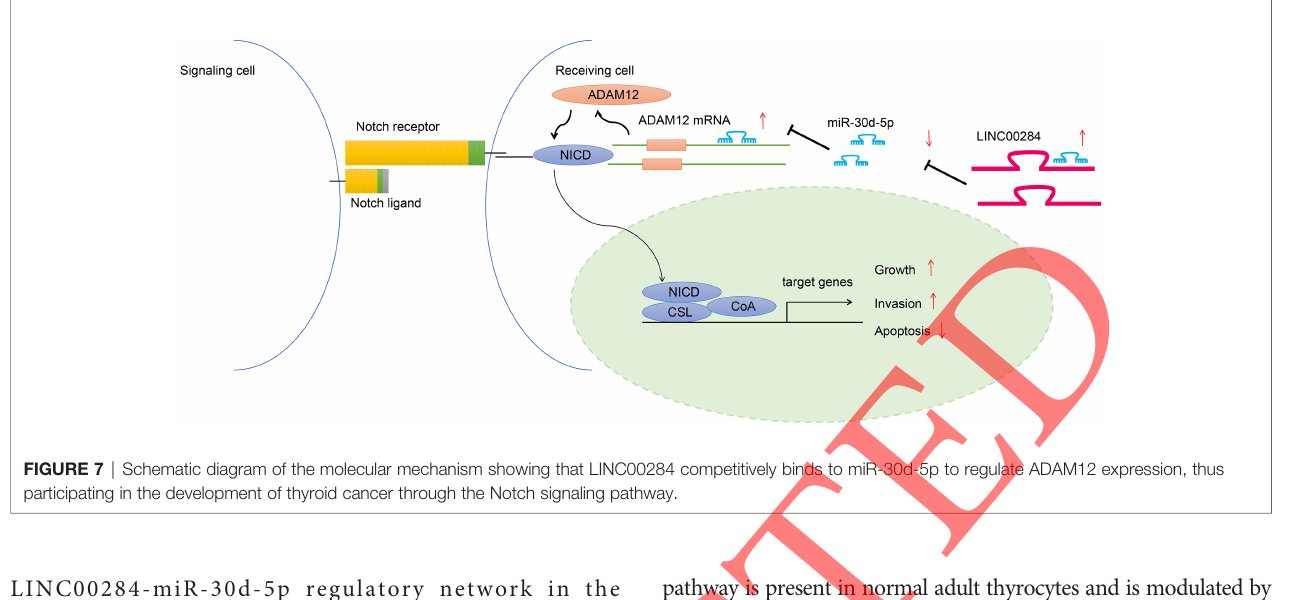
FIGURE 7 | Schematic diagram of the molecular mechanism showing that LINC00284 competitively binds to miR-30d-5p to regulate ADAM12 expression, thus participating in the development of thyroid cancer through the Notch